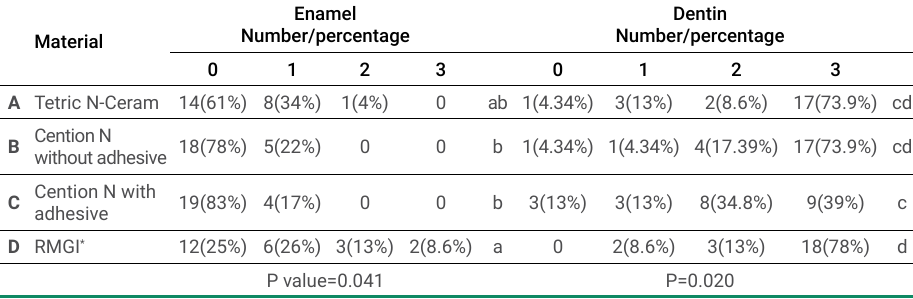
Similar letters show that the distribution of the leakage scores are not significantly different. *RMGI: Resin-modified glass